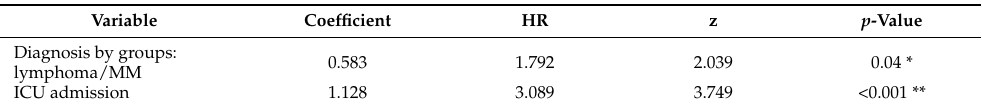
Table 5. Multivariate analysis for overall